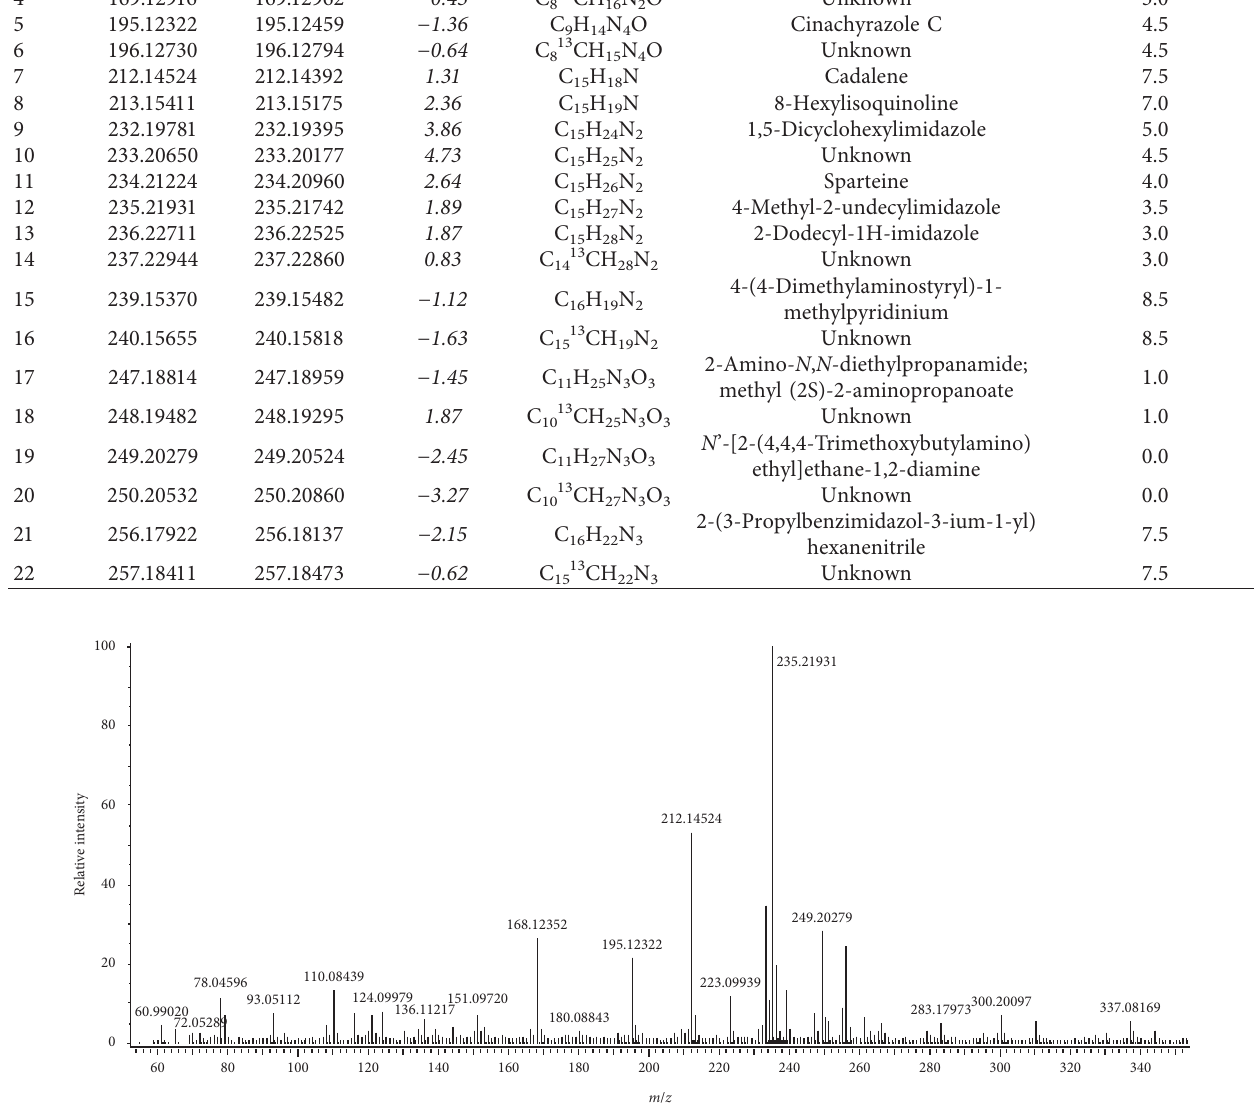
Figure 1: Main constituents characterized in R. raetam plant stem by